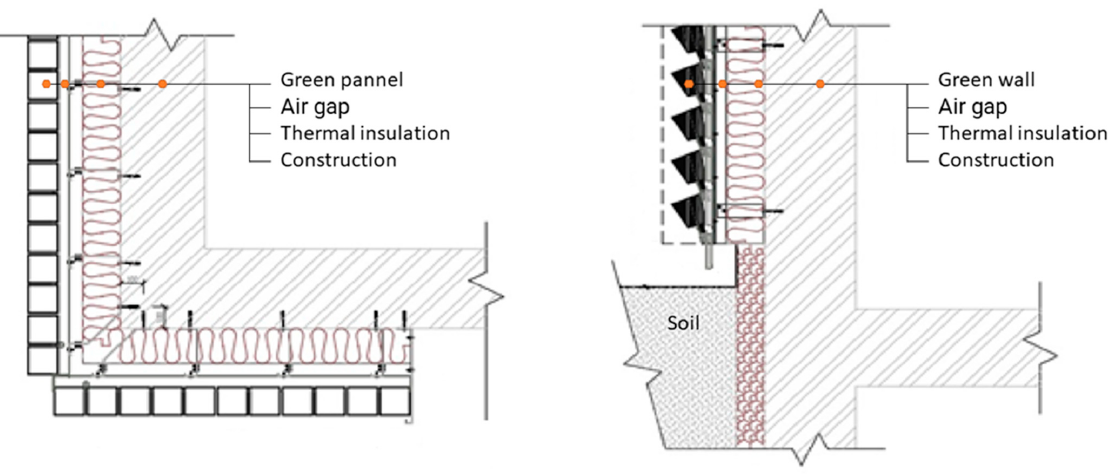
Figure 3. Diagram of a vertical garden—exterior with insulation [42].